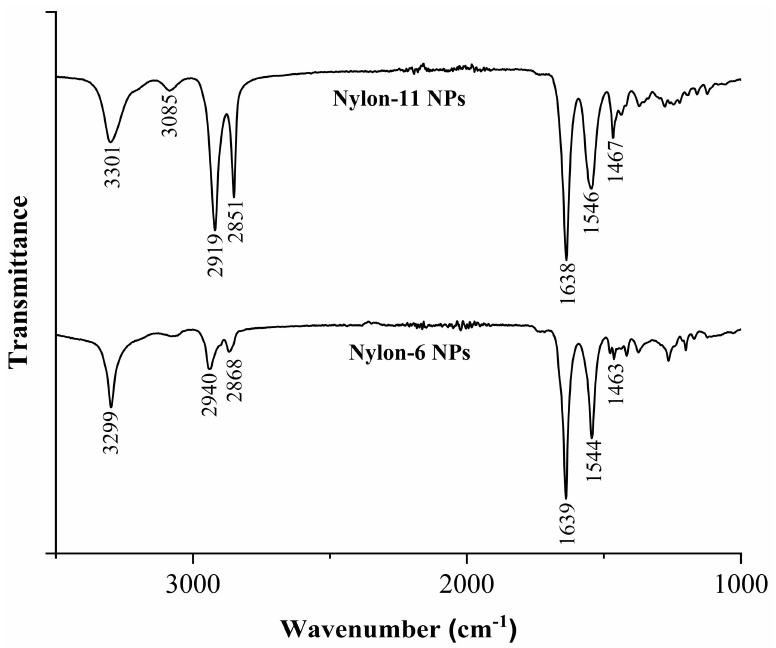
Figure 3. FT − IR spectra of nylon − 11 NPs ( top ) and nylon − 6 NPs ( bottom